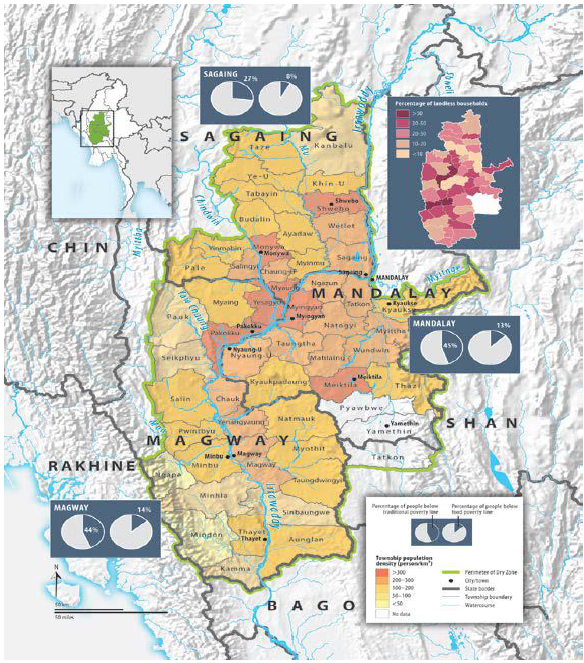
Figure. 1. The demographics of Myanmar's Dry Zone, showing the population density of townships and distribution of landless households. (Source: Boundary/townships as defined by the Myanmar Information Management Unit [MIMU] [Map Id.: MIMU983V01], March 2013 [www.themimu.info/]; Statistics on population density, poverty and landless households from